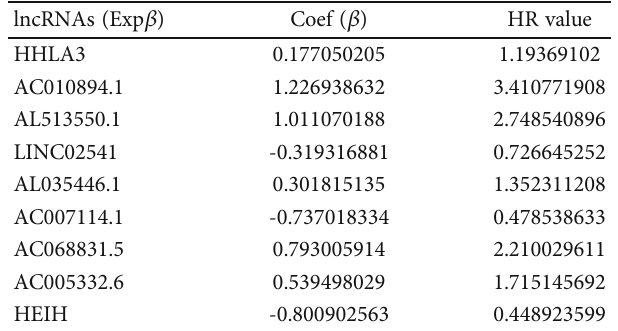
Table 3: Coe ffi cient pro fi les of the nine m7G-related prognostic